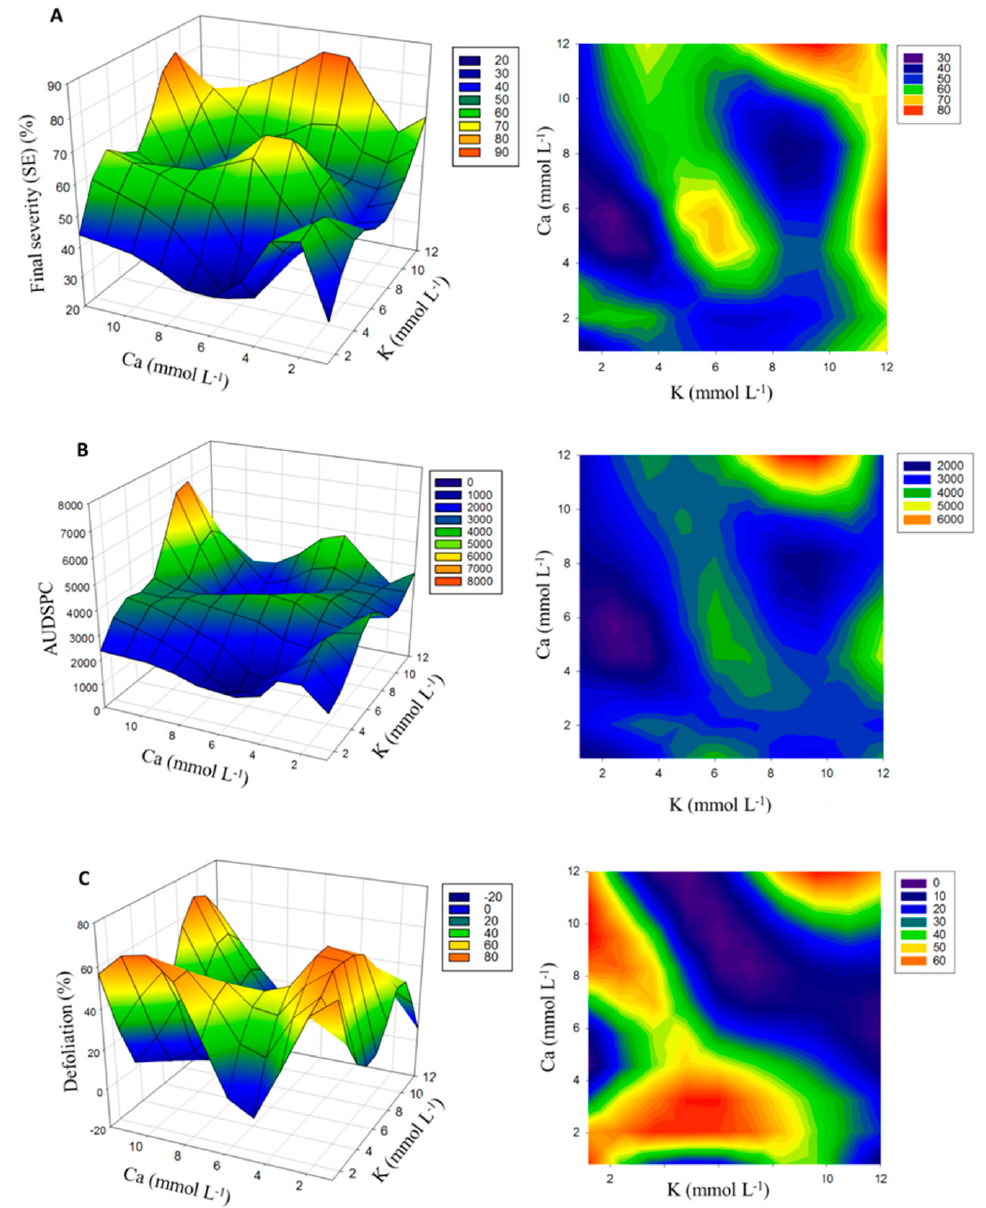
Figure 2. Influence of the supply of Ca and K (mmol L − 1 ) on the final severity (FS) ( A ), area under the disease progression curve (AUDPC) ( B ) and defoliation ( C ) of eucalyptus seedlings.